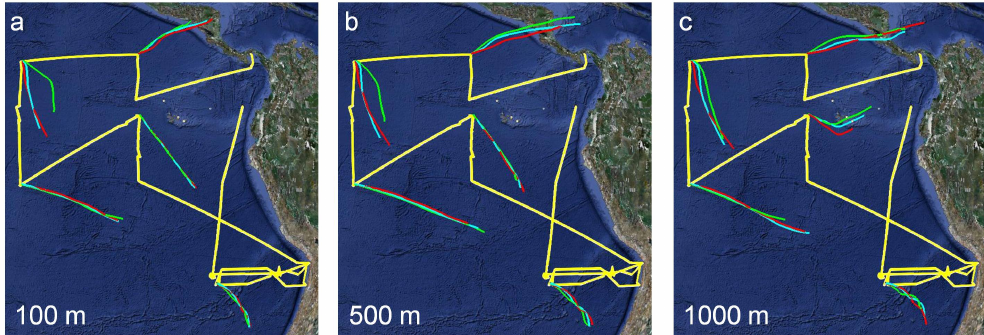
Fig. 4. 48h HYSPLIT (HYbrid Single-Particle Lagrangian Integrated Trajectory) backward trajectory calculations for corner points of the cruise (yellow line) at the days the ship was there (Draxler and Rolph, 2010; Rolph, 2010). The trajectories are calculated for the morning (green), midday (turquoise) and evening (red) each for air mass heights at the starting points of (a) 100 m, (b) 500 m and (c) 1000 m (satellite underlay pictures: Google